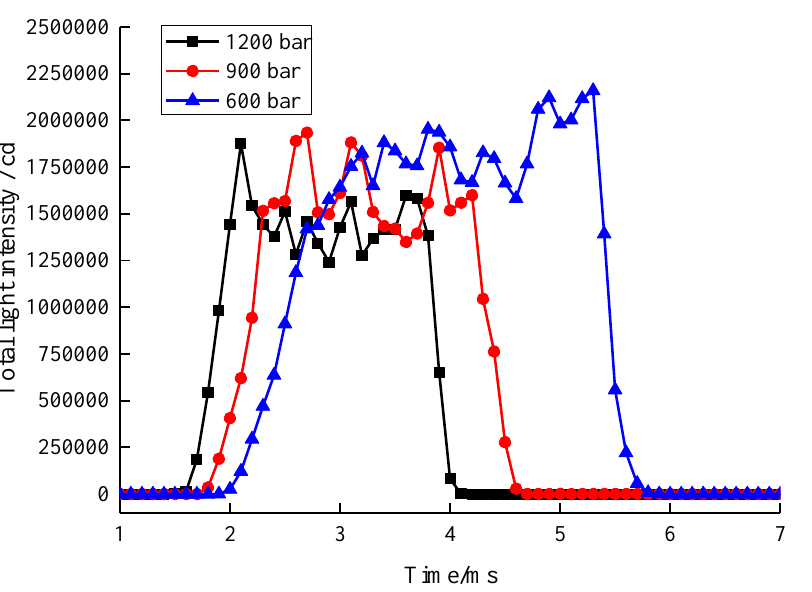
Figure 8. Comparison of total light intensity of constant volume combustion vessel in a 50% O 2 nitrogen-free environment.